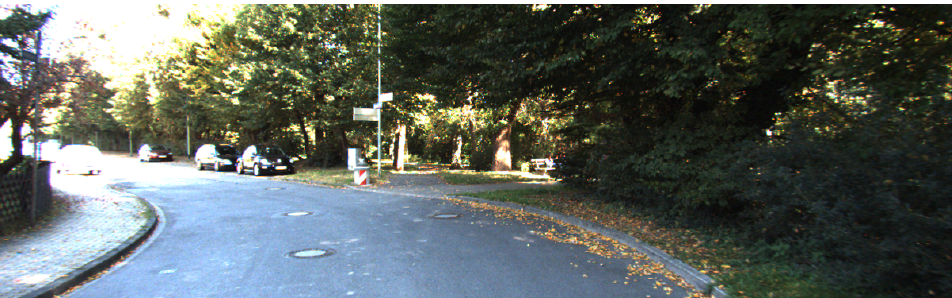
Figure 10. The most critical section for our proposal: the vehicle is surrounded by trees and hedges at a